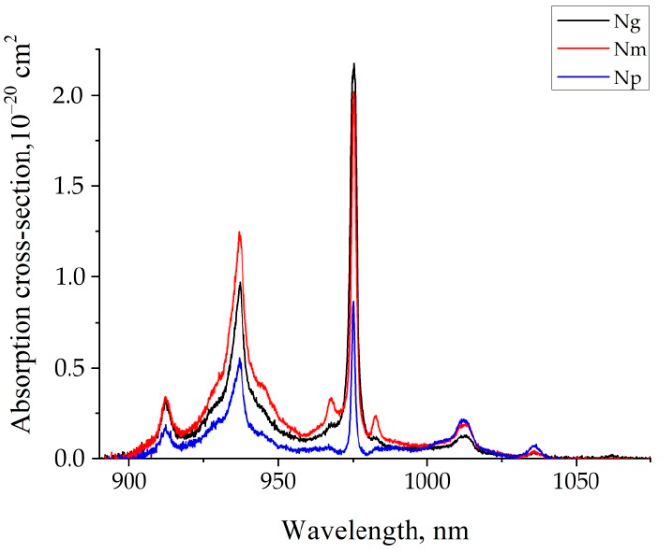
Figure 6. Powder X-ray diffraction pattern of products obtained after TGA-DSC experiments in the temperature range 50–1100 ° C. PXRD analysis indicated the presence of YBO 3 and Mg 2 B 2 O 10 phases. The obtained absorption cross-section spectra of the Yb:YMBO crystal are shown in Figure 7.